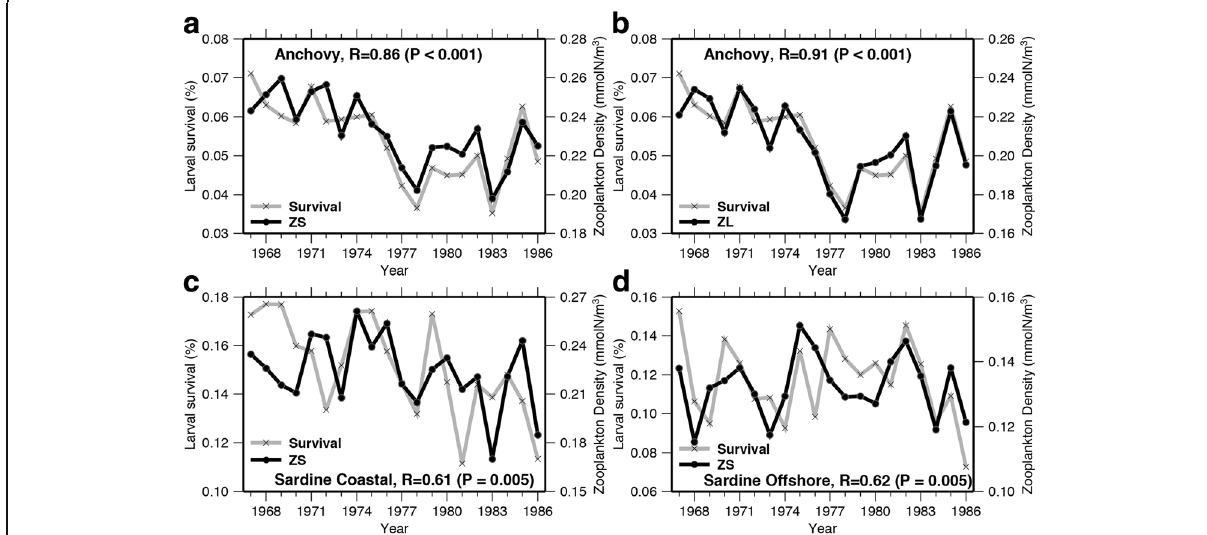
Fig. 10 Comparison between larval stage survival of anchovy and sardine and zooplankton densities. Time series of simulated a ambient small zooplankton (ZS) density (black line with closed circles) and larval stage survival of anchovy (gray line with crosses), b ambient large zooplankton (ZL) density and anchovy larval survival, c ambient ZS density and larval stage survival of coastal sardine, and d ambient ZS density and larval stage survival of offshore sardine. R denotes the correlation coefficient, and P denotes the probability value. Zooplankton density is the values recorded concurrently as what each larval individual experienced and is averaged accounting for the worth of the different